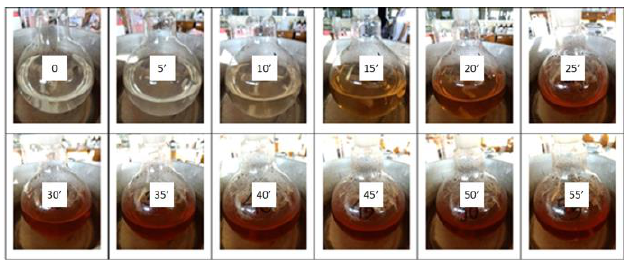
Fig. 5. Photographs of silver nanoparticles synthesis steps for Sample A at AgNO 3 solution concentration of 0.05